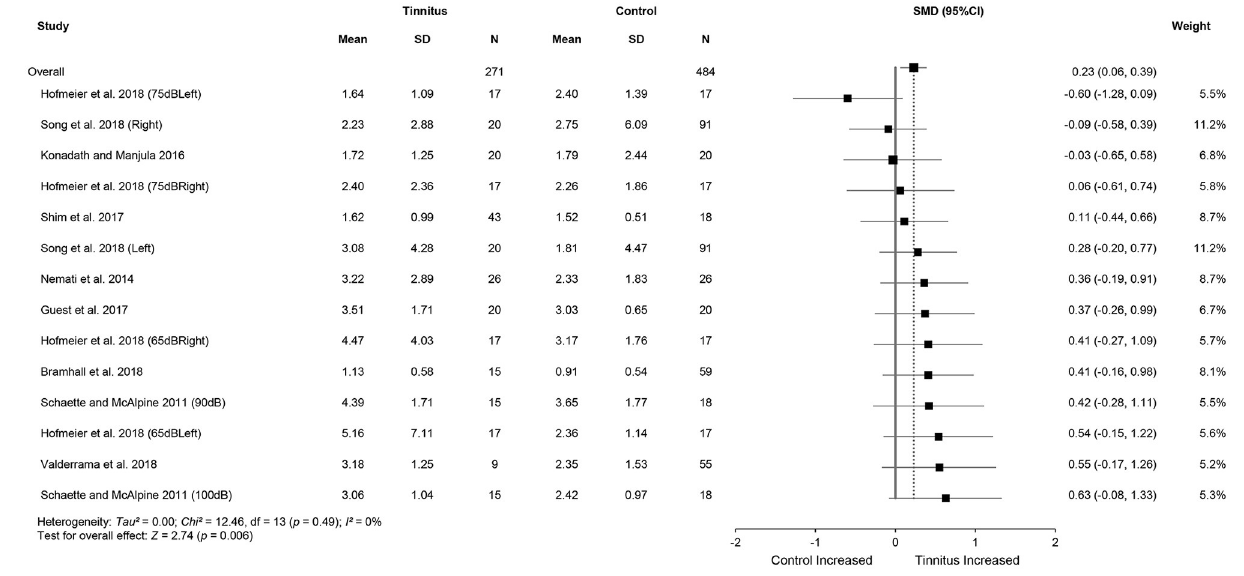
heterogeneity and increased wave V/I amplitude ratios. The changes in wave V amplitudes were inconsistent. No interaction was identified by subgroup analysis to explain the heterogeneity shown in reduced wave I amplitudes.